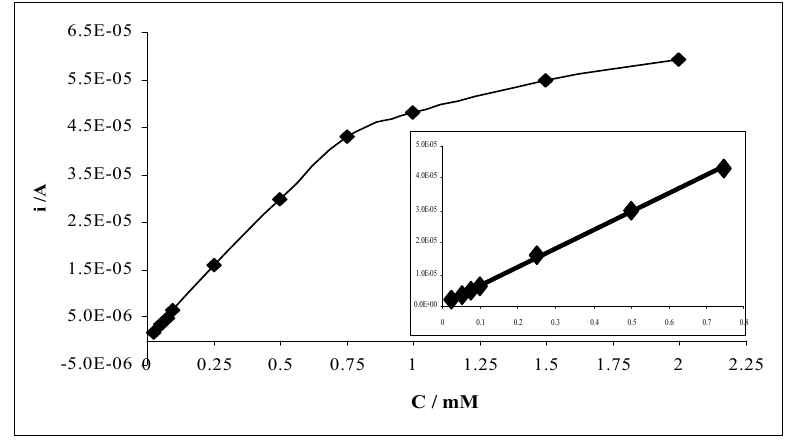
Figure 7. The calibration curves of sulfamethoxazole between peak current and concentration of sulfamethoxazole at MIP electrode.